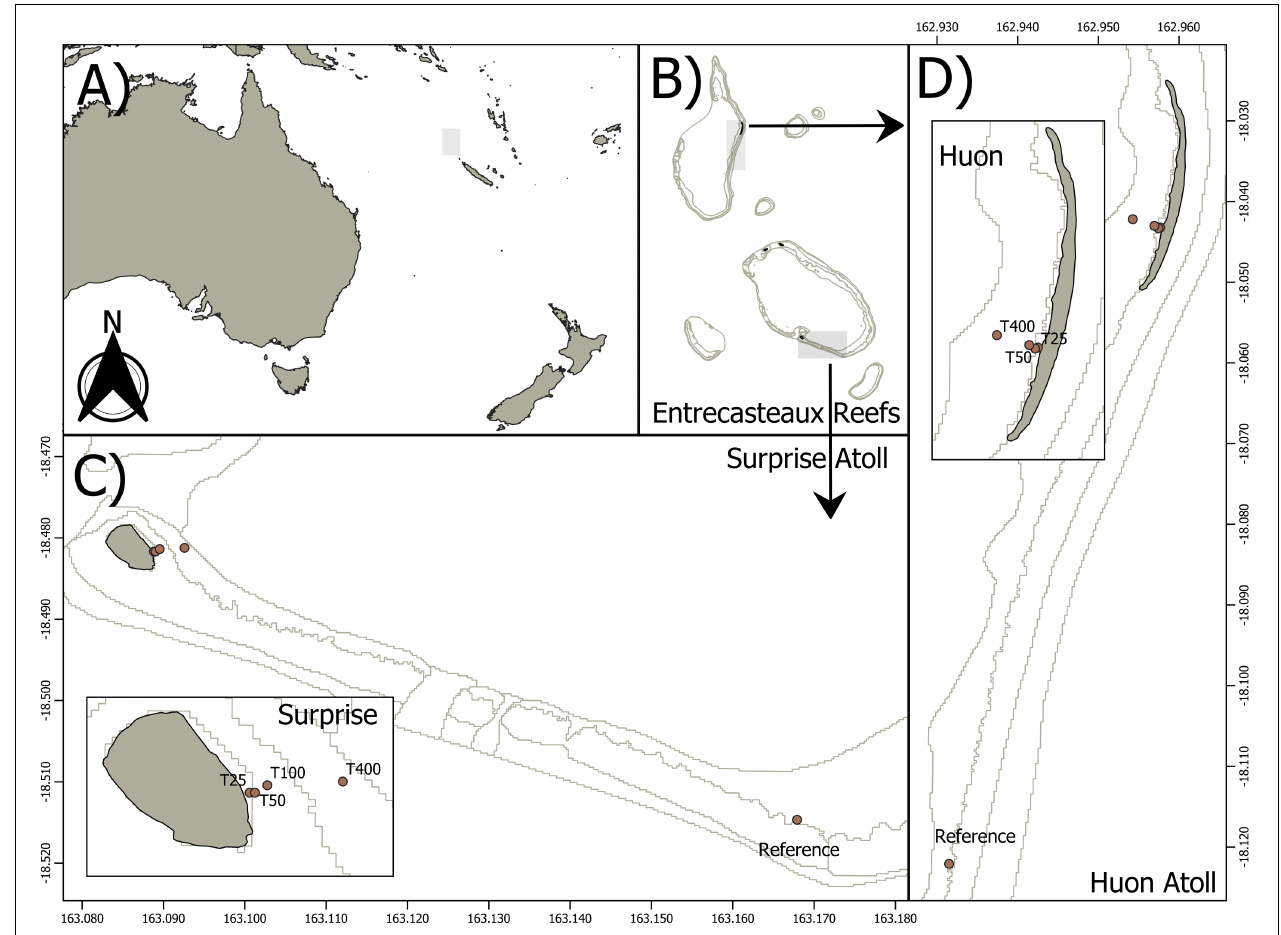
FIGURE 1 | Study sites location. (A) Location of New Caledonia and the D’Entrecasteaux reefs in the South Pacific. (B) The two study atolls, Surprise and Huon, within the d’Entrecasteaux reefs. (C) Location of our transect and reference site within Surprise atoll. (D) Location of our transect and reference site within Huon